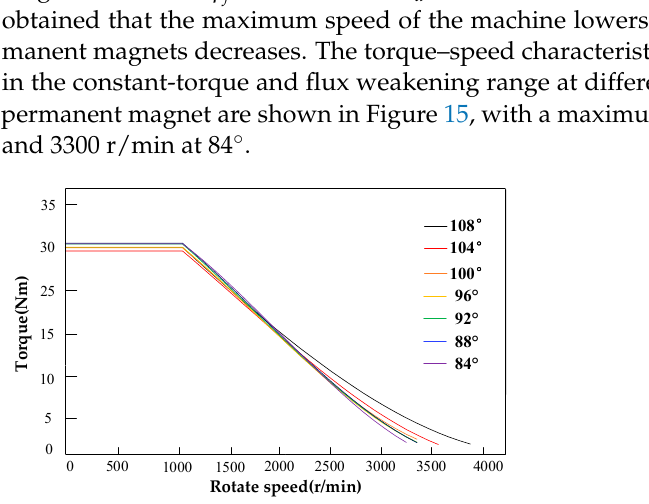
( b ) Figure 14. ( a ) Electromagnetic torque with different angle between the V-type permanent magnets; ( b ) The average value of electromagnetic torque and torque ripple with different angle between the V-type permanent magnets.